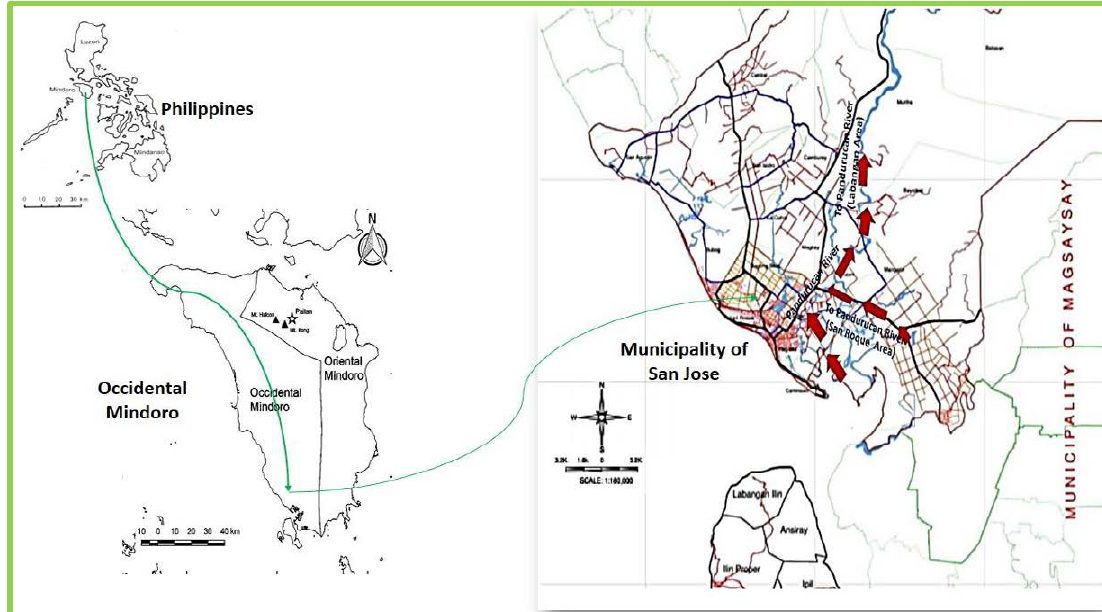
Fig. 3: Geographic location of the study area along with the existing drainage system in San Jose, Occidental Mindoro, Philippines Table 3: Average concentrations of physical-chemical parameters Physical-chemical parameters Temperature ( ˚C )